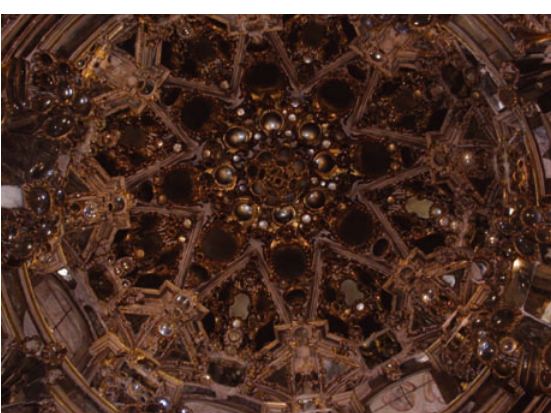
Figure 1. Photografy of Sample 4: Camerin Virgen del Rosario in the Santo Domingo Convent